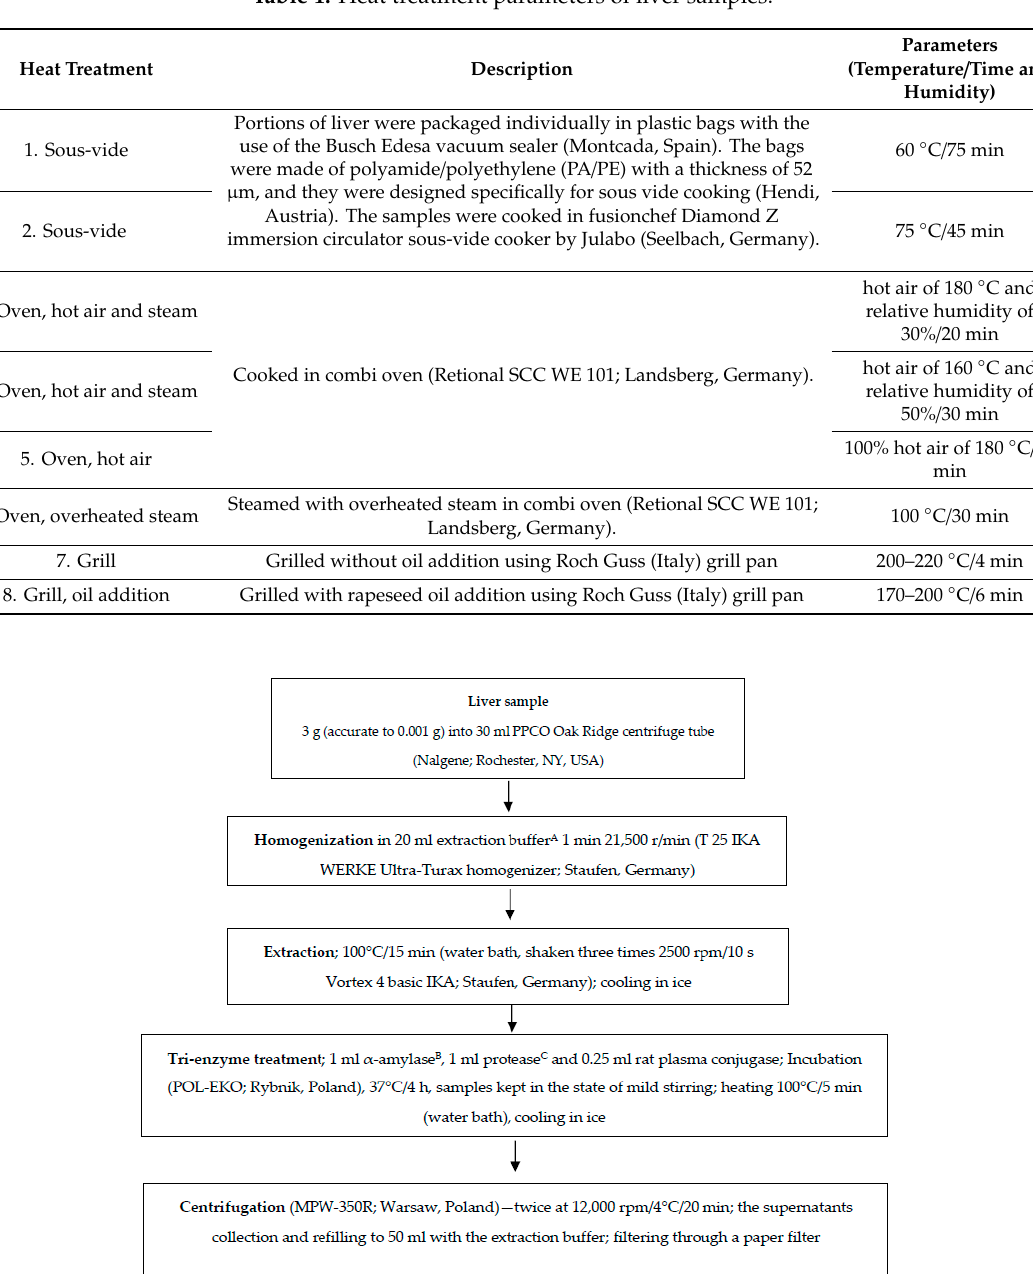
Table 1. Heat treatment parameters of liver samples.